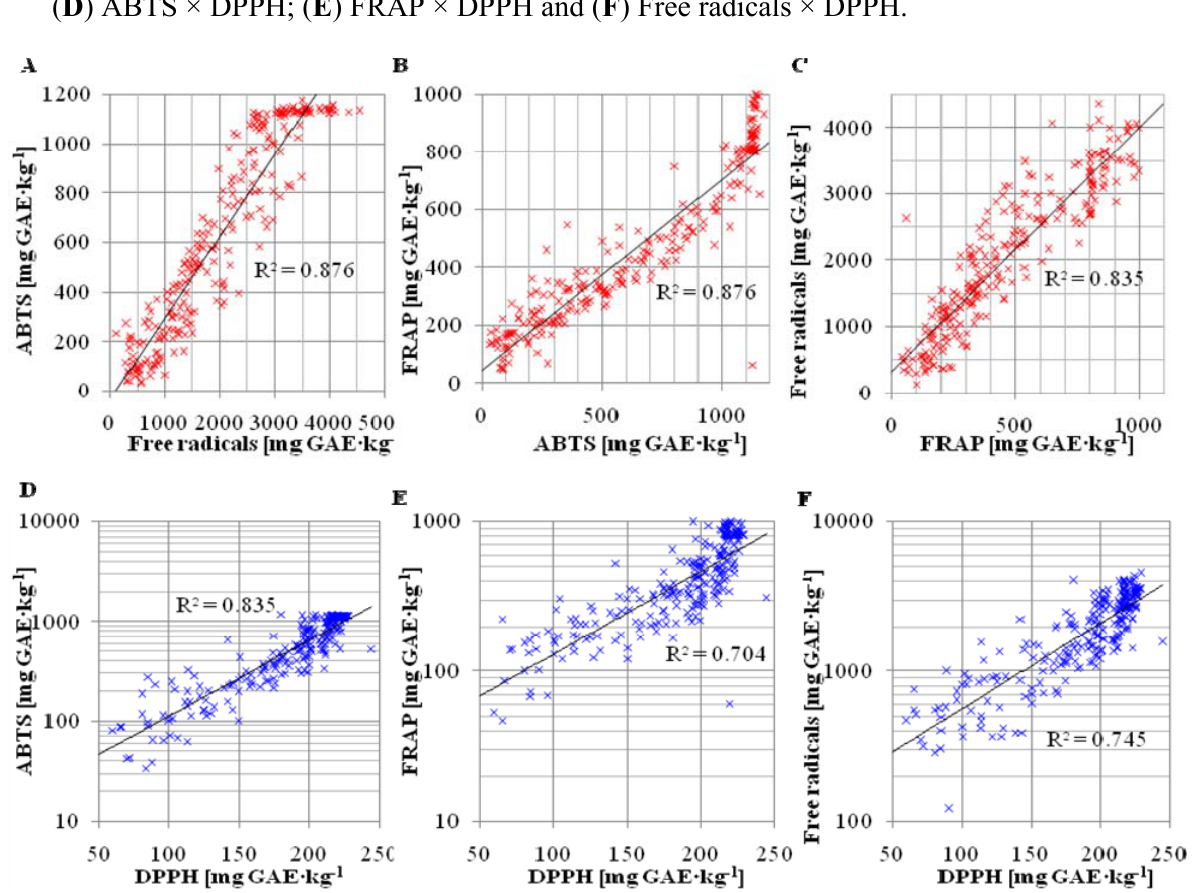
Figure 9. Correlograms between methods for determination of antioxidant activity as follows: ( A ) ABTS × Free radicals; ( B ) FRAP × ABTS; ( C ) Free radicals × FRAP; ( D ) ABTS × DPPH; ( E ) FRAP × DPPH and ( F ) Free radicals × DPPH.